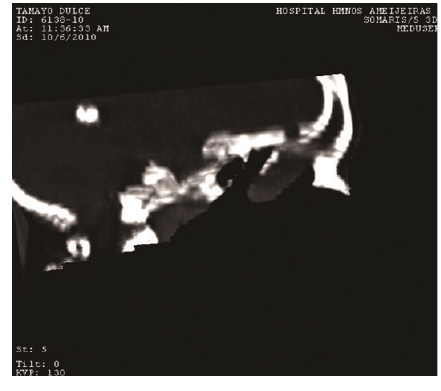
Figure 3: CT scan.